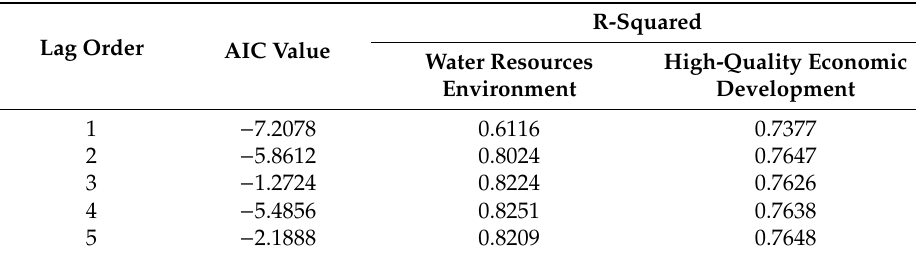
Table 3. Determination of the lag order of the vector autoregressive (VAR)